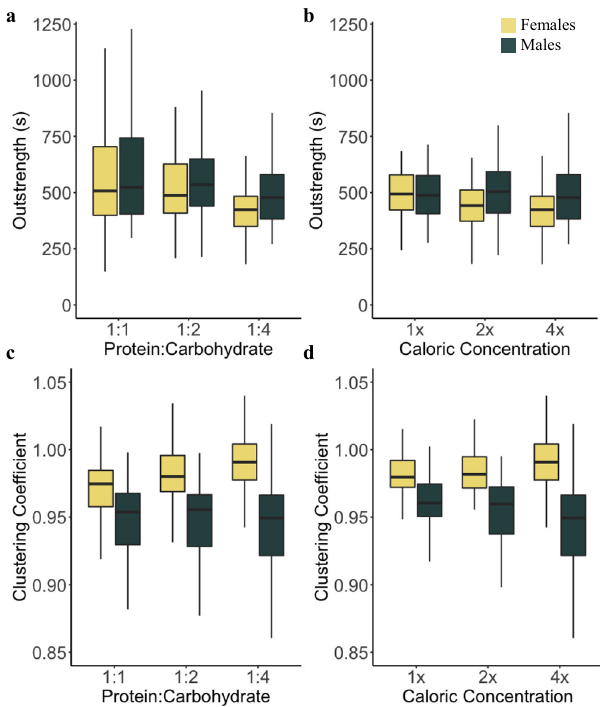
Fig. 2 Sex-by-nutritional environment effects on network position. Sex differences in outstrength ( a , b ) and clustering coef fi cient ( c , d ) signi fi cantly differed across nutritional environments of varying protein-to- carbohydrate ratio ( a , c ) and caloric concentration ( b , d ). Boxplots present the medians (horizontal lines), interquartile ranges (boxes), and values within ± 1.5x IQR (whiskers) for each sex in each nutritional environment (1:1 – 1:4, 1x – 4x; n = 160, 120, 130, 50, 100, 130, respectively for each sex). Sexes are delineated by the color fi ll of the boxplots (yellow = females, navy = males). Source data are provided as a Source Data fi